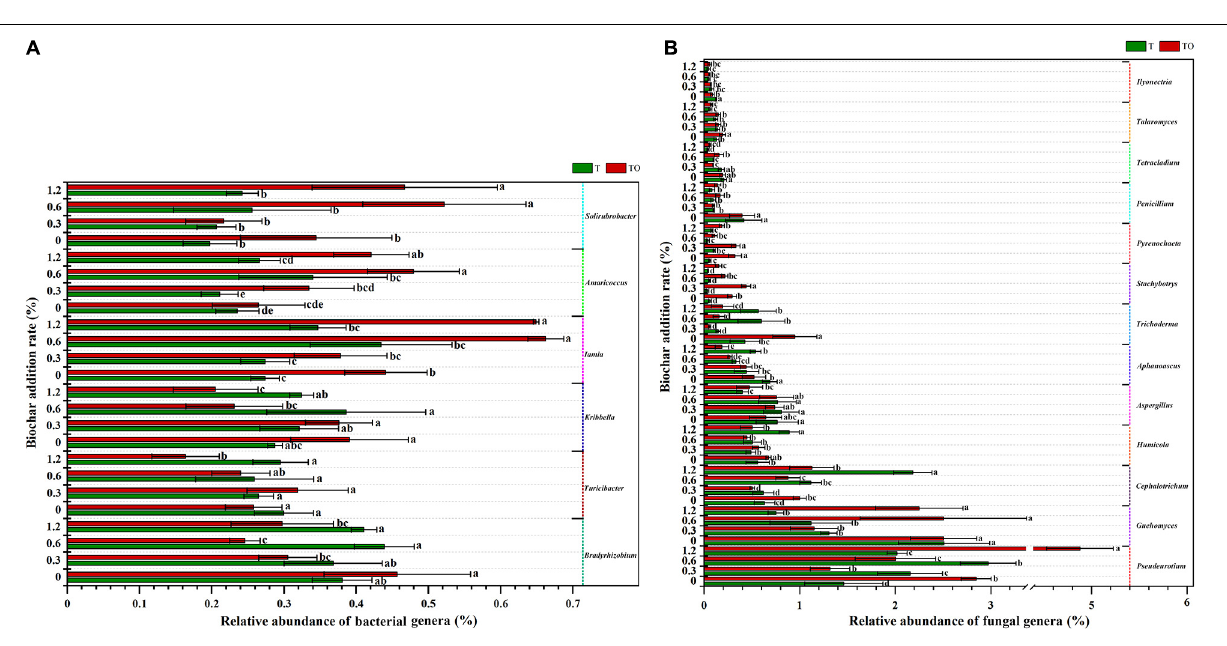
FIGURE 5 | The relative abundances of bacterial genera (A) and fungal genera (B) in tomato rhizosphere soil changed significantly in the top 50 after 30 days pot experiment in 2019. T and TO indicate tomato monoculture and intercropped with potato–onion, respectively. 0, 0.3, 0.6, and 1.2 indicate the biochar rates (%) on the Y-axis. Different letters indicate the statistically significant differences among treatments ( P <